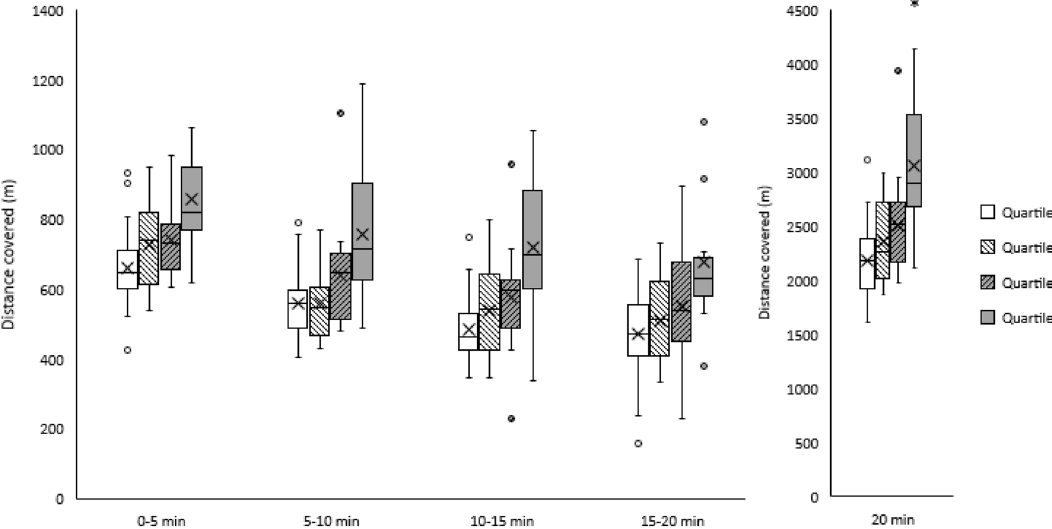
Figure 3. Distance covered (m) by participants in each fitness quartile (Quartile 1: lowest fit, Quartile 4: highest fit) during each 5 min split and the total 20 min of The Daily Mile. Main effect of fitness, p < 0.001. * Indicates distance covered by participants in quartile 4 greater than participants in quartiles 1, 2 and 3 (all p <